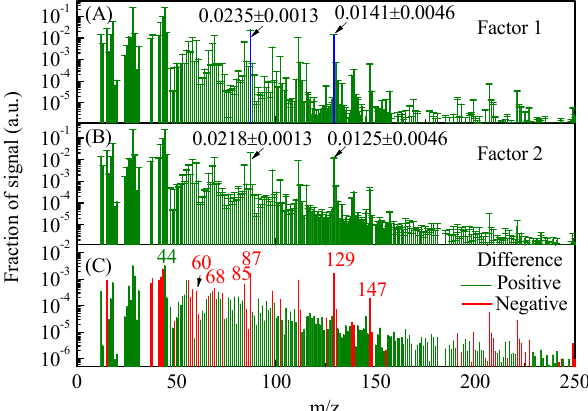
Figure 3. Mass spectra (a) of CA from NIST database, (b) of pure CA measured with the C-ToF-AMS.